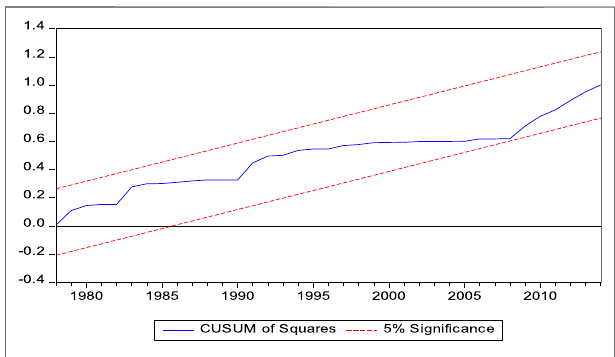
FIGURE 8 | CUSUMSQR energy